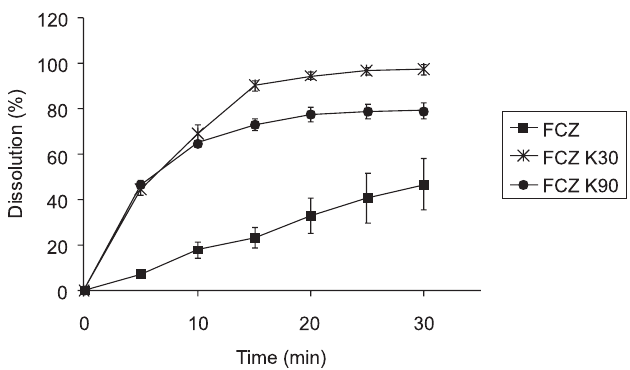
FIGURE 1 - Drug dissolution profile from capsules with fluconazole (FCZ) and fluconazole granules (FCZ K30 and FCZ K